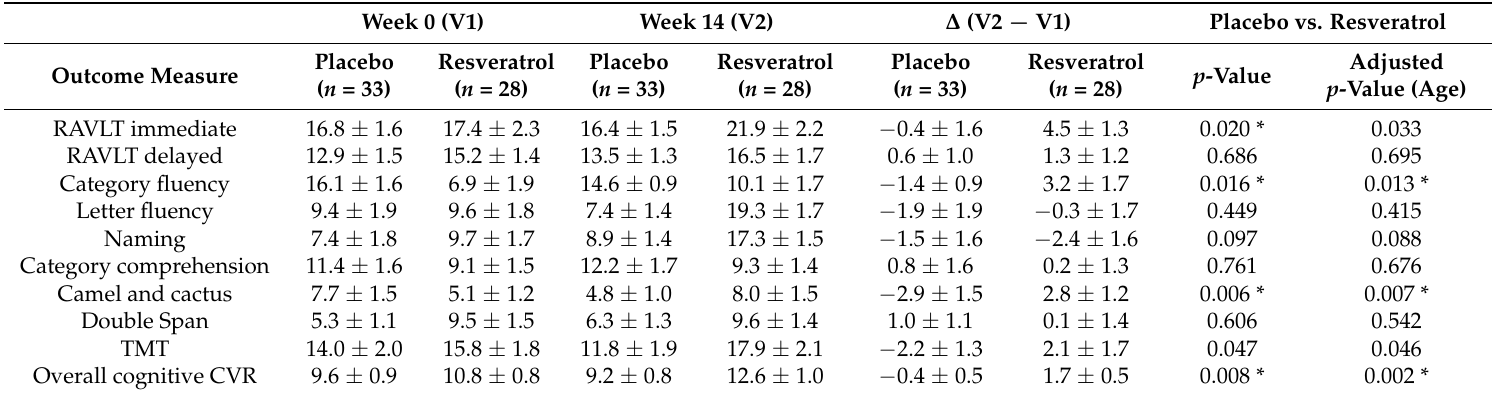
Table 3. Cerebrovascular responsiveness (percentage) for individual cognitive tasks and overall cognitive cerebrovascular responsiveness (CVR). Data are presented as mean ± SEM.